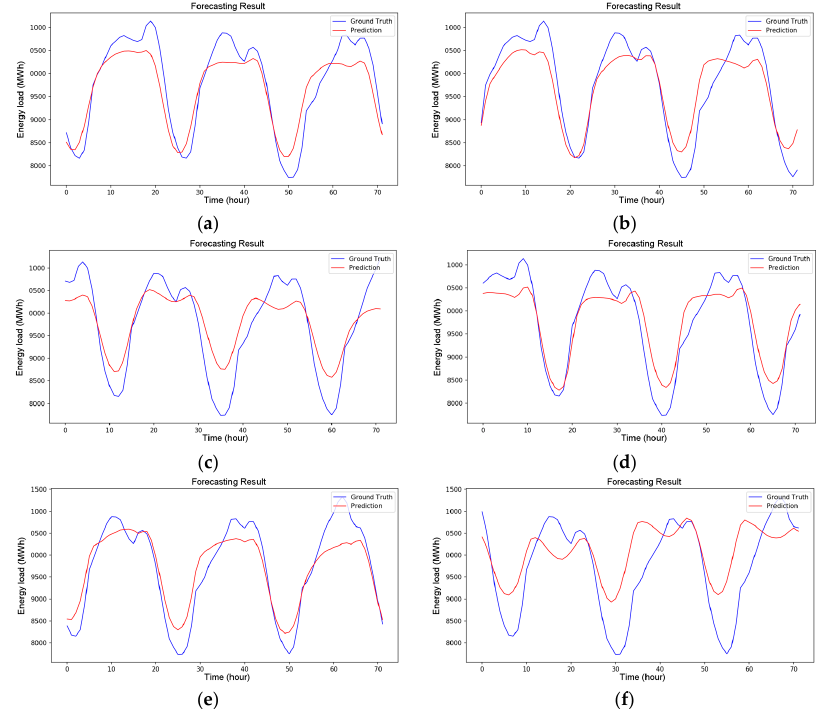
Figure 7. The forecasting results of random forest (RF): ( a ) Partial results A; ( b ) Partial results B; ( c ) Partial results C; ( d ) Partial results D; ( e ) Partial results E; ( f ) Partial results